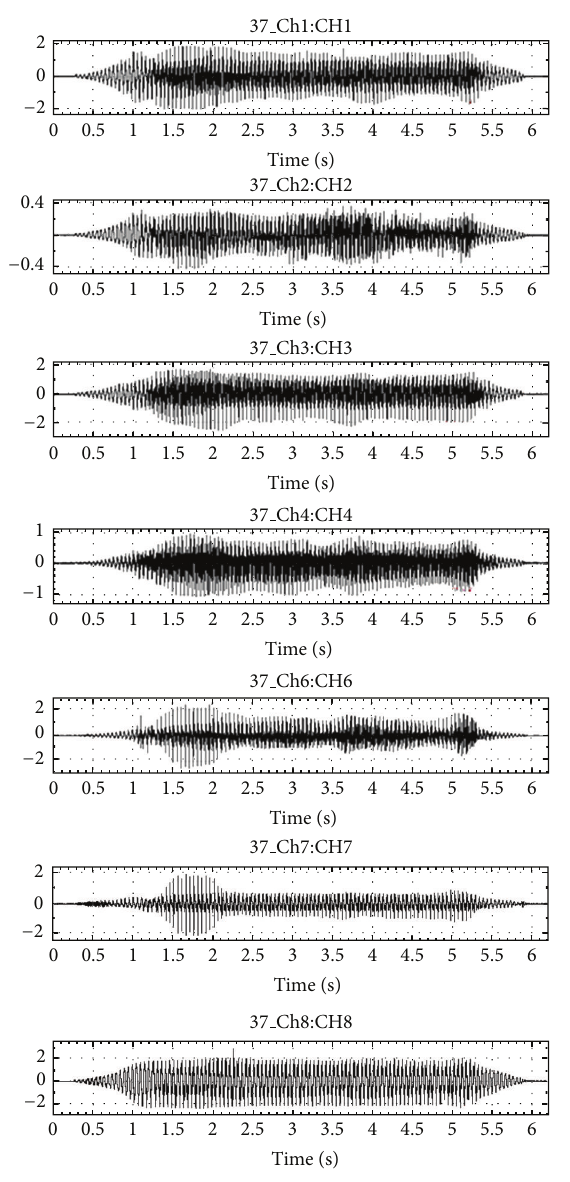
Figure 25: Microseism signals of working condition 37.